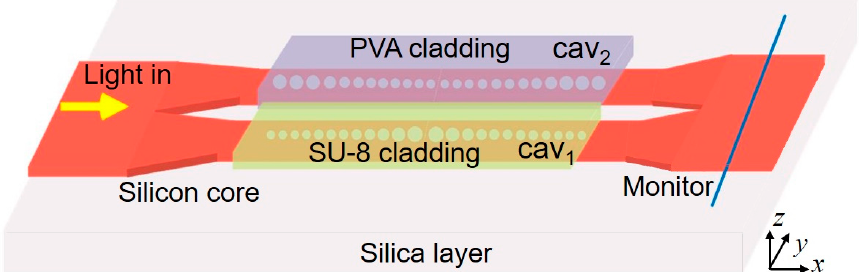
Figure 1. Schematic diagram of the proposed SOI ‐ based cascaded photonic crystal nanobeam cavities (PCNCs) dual ‐ parameter sensor. The dielectric ‐ mode nanobeam cavities (cav 1 ) are covered by SU ‐ 8 cladding (light yellow region), while the air ‐ mode nanobeam cavities (cav 2 ) are coated with a layer of PVA upper cladding (light blue region).